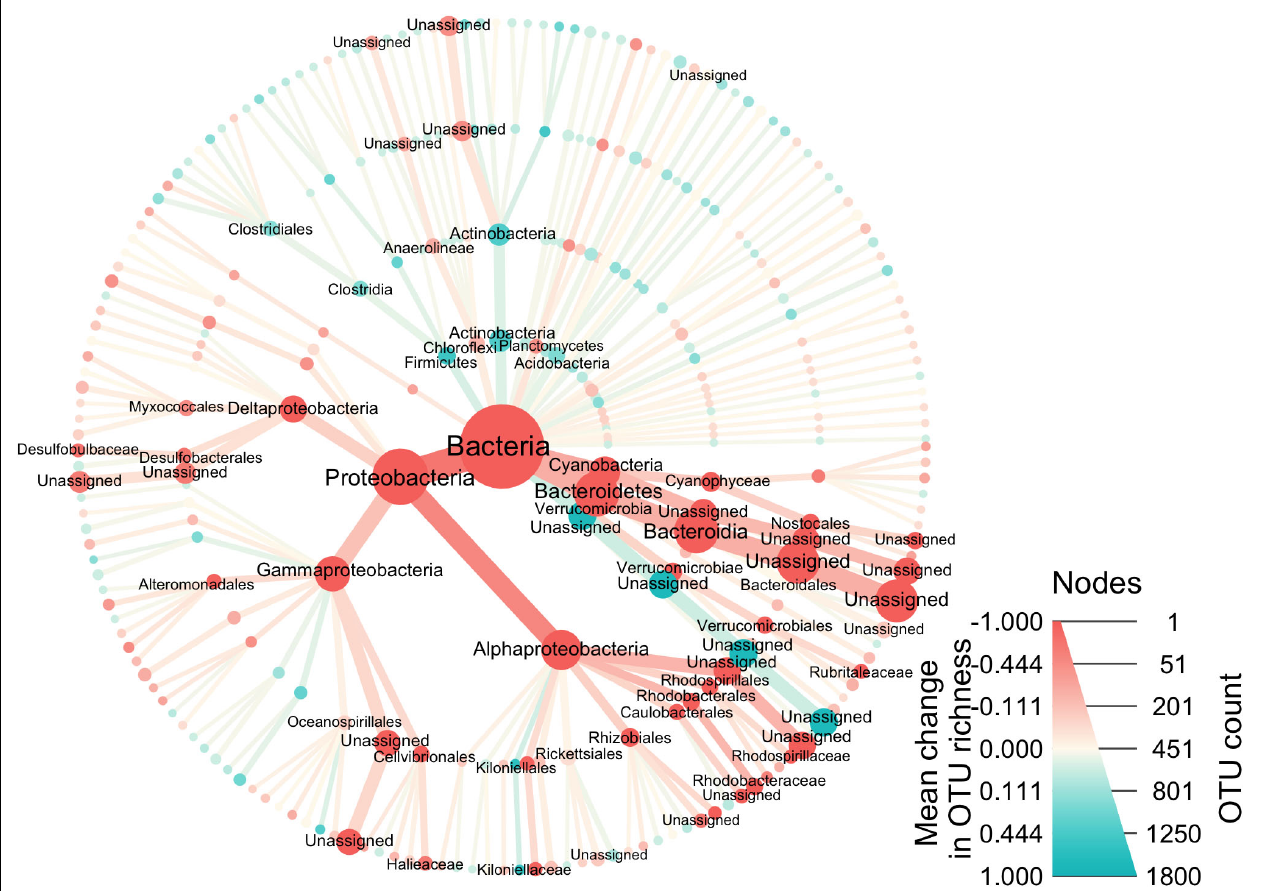
FIGURE 5 | This phylogenetic heat tree shows the bacteria composition of the samples. The color of nodes and edges represents the mean change in OTU richness at each taxonomic group, with red indicating greater richness in lesional samples and blue in the non-lesional, while node size represents OTU richness of each taxonomic group across the